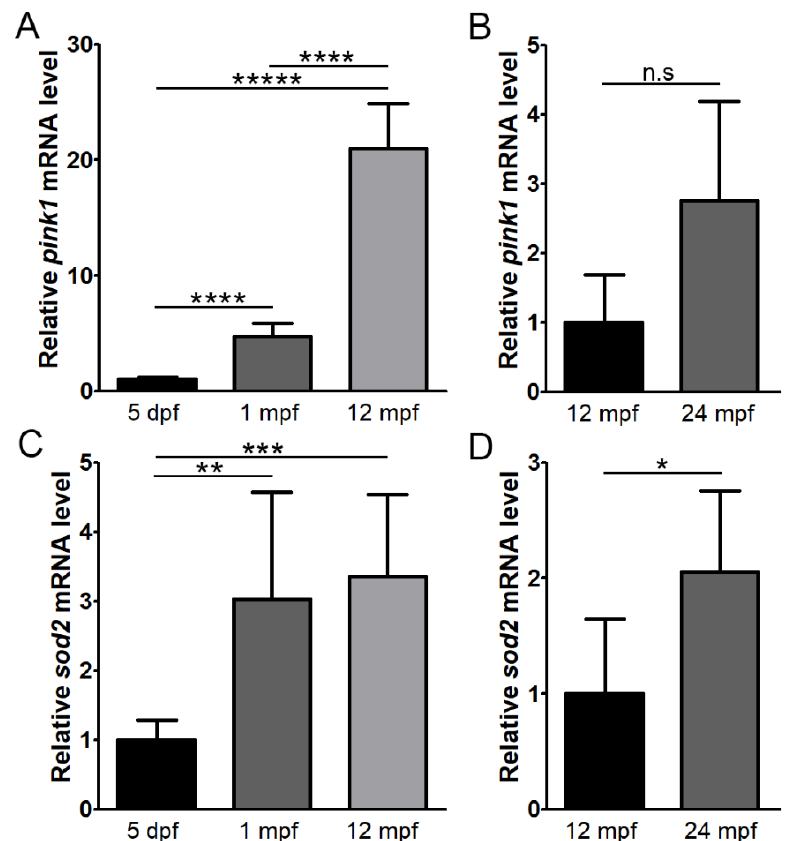
Figure 7. Expression levels of pink1 and sod2 with age in the zebrafish retina. RT-qPCR was performed to assess expression of pink1 ( A , B ) and sod2 ( C , D ) at 5 days post-fertilisation (dpf), 1 month post-fertilisation (mpf), 12 mpf and 24 mpf (n = 5). * p < 0.05; ** p < 0.01; *** p < 0.001; **** p < 0.00001; ***** p < 0.0000001; n.s, not significant.